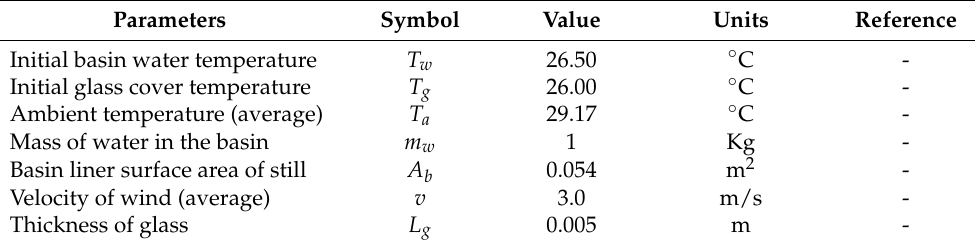
Table 5. Physical input design parameters of the solar still